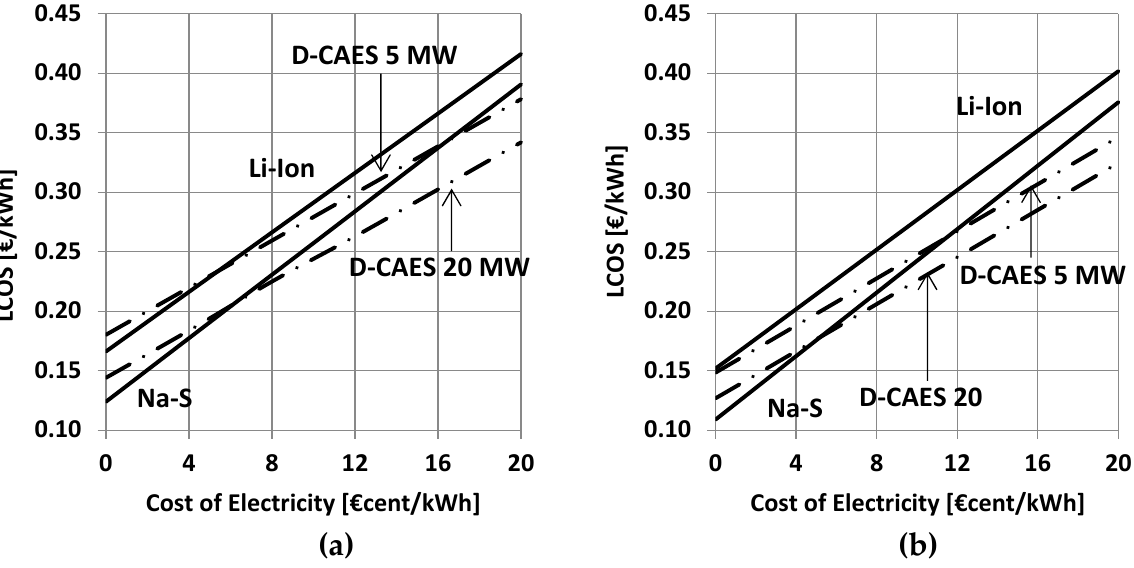
Figure 5. LCOS by varying the cost of electricity absorbed during the charging phase: ( a ) Case t CH = t DS = 6 h; ( b ) Case t CH = t DS = 10 h.